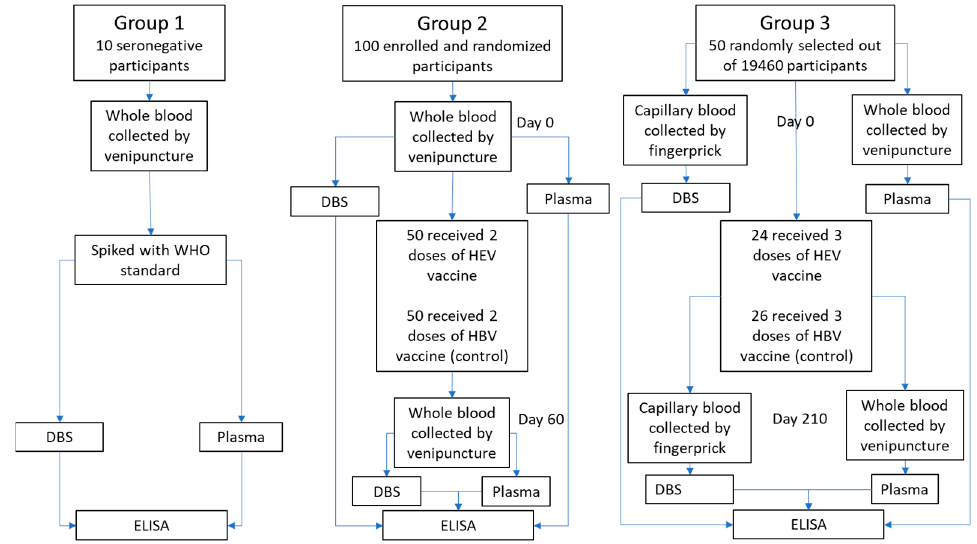
Figure 1. Flow chart of sample processing for the three different source materials used in this